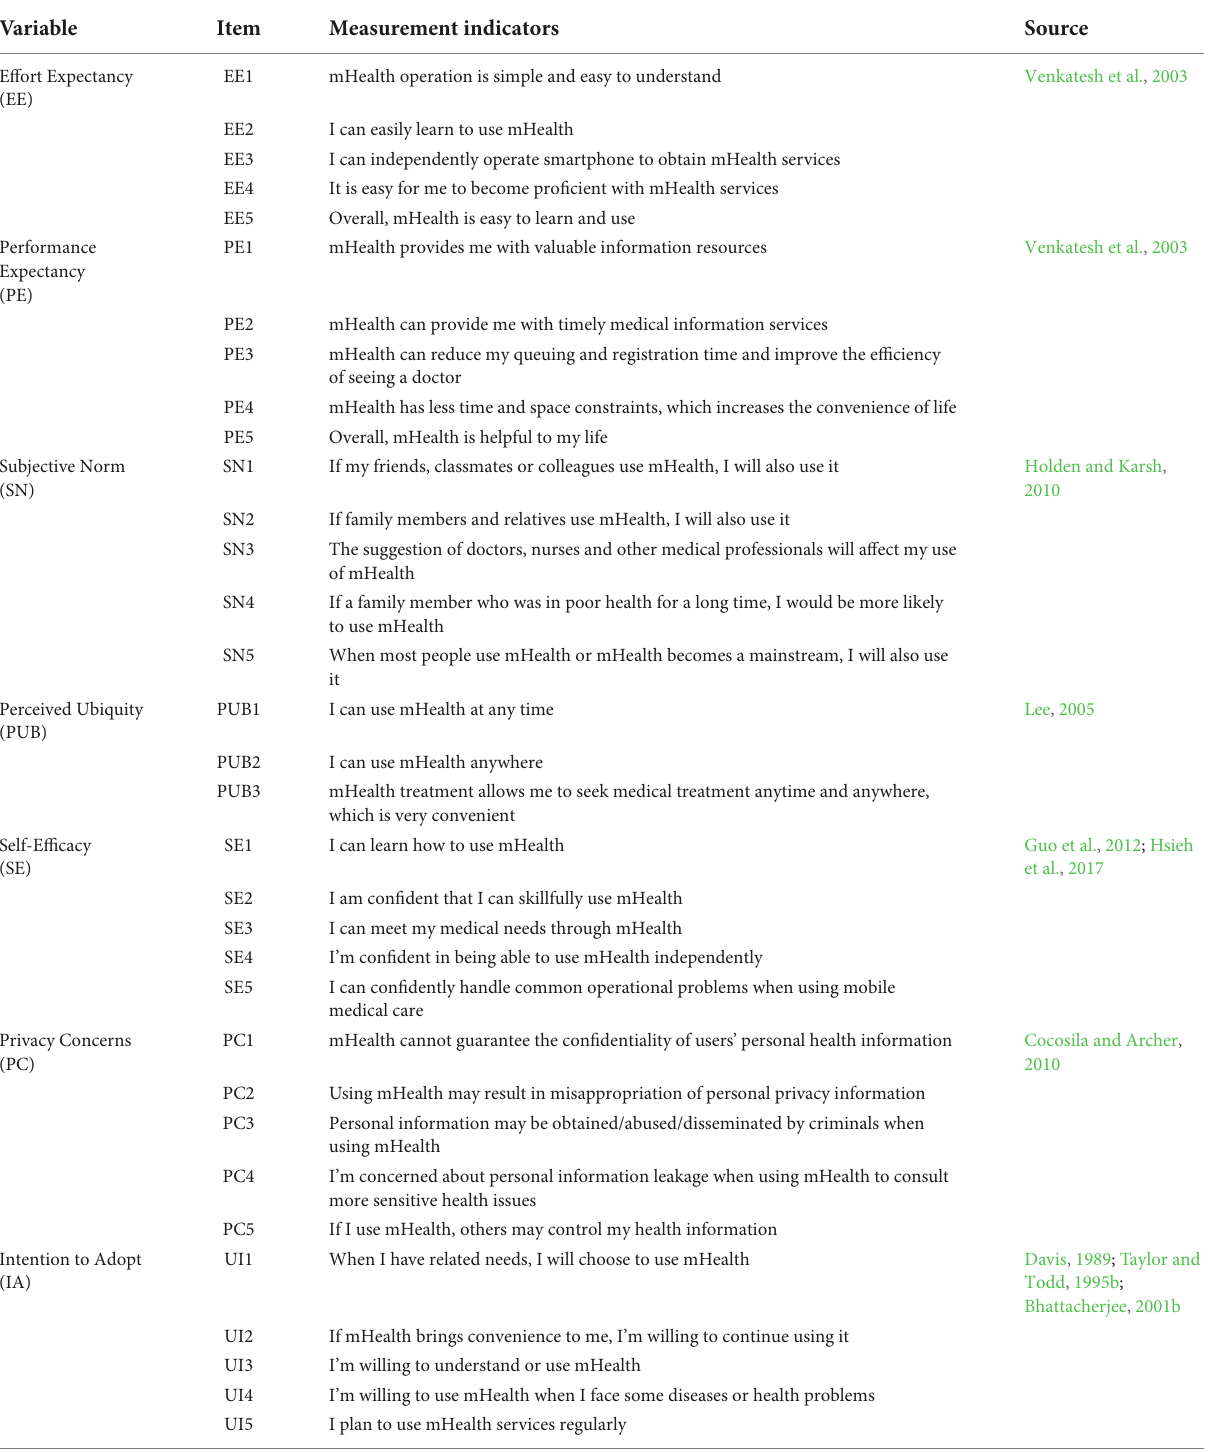
TABLE 2 Measuring variables and